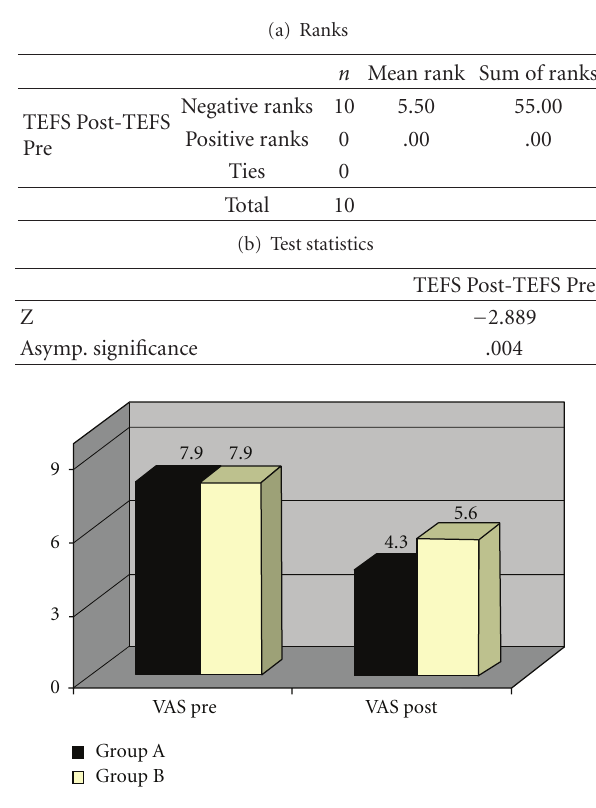
Figure 7: Comparison of VAS scores of two